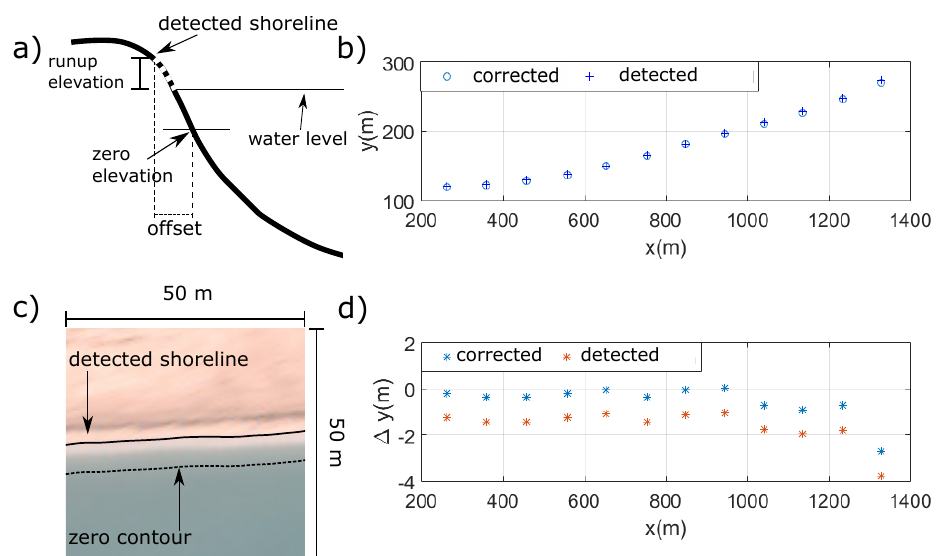
Figure 5. Sketch representing the offset between the 0-m elevation and the detected shoreline position ( a ), corrected and detected shorelines on 25 August 2015 ( b ), cropped planview image ( c ), and the difference between the measured shoreline and the corrected and detected shorelines ( d ).